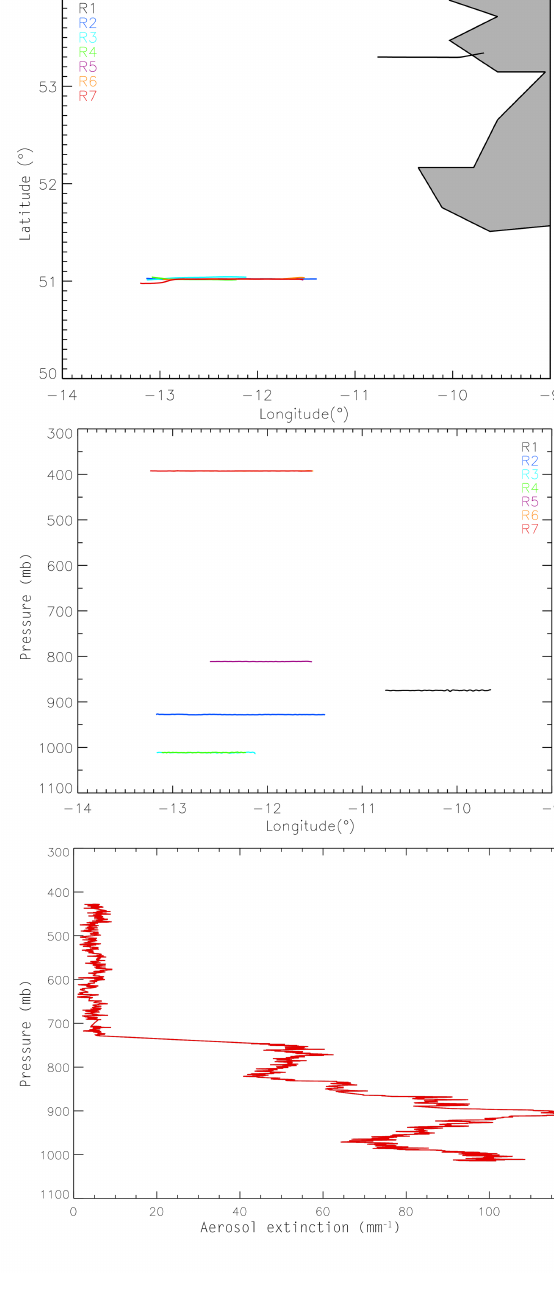
Figure 1. Flight b374 pattern for each SLR as a function of geo- graphic location showing the southwest of Ireland shaded grey (top) and the pressure at which the measurements were made (middle). Vertical profile of aerosol extinction at 550nm during flight b374